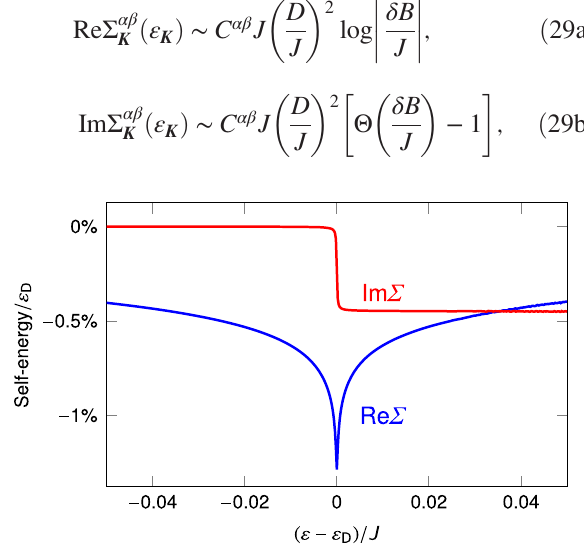
FIG. 6. Sketch of an element of the self-energy matrix at the lower threshold of the two-magnon continuum for D=J ¼ 0 . 15